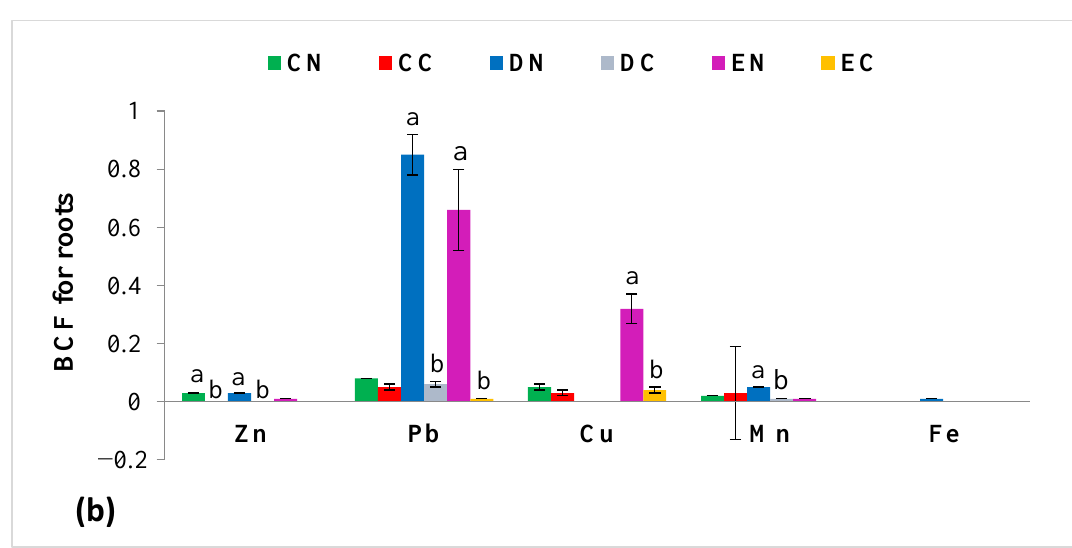
Figure 2. Bioaccumulation factor for leaves ( a ) and roots ( b ) of C. salviifolius , D. viscosa , and E. pithyusa in contaminated soil (C) and uncontaminated soil (NC). The mean and standard error bars of the mean are indicated. The non-parametric Kruskal-Wallis test was applied. Different letters indicate significant differences at a significance level <0.05 for the same plant growing on contaminated and uncontaminated